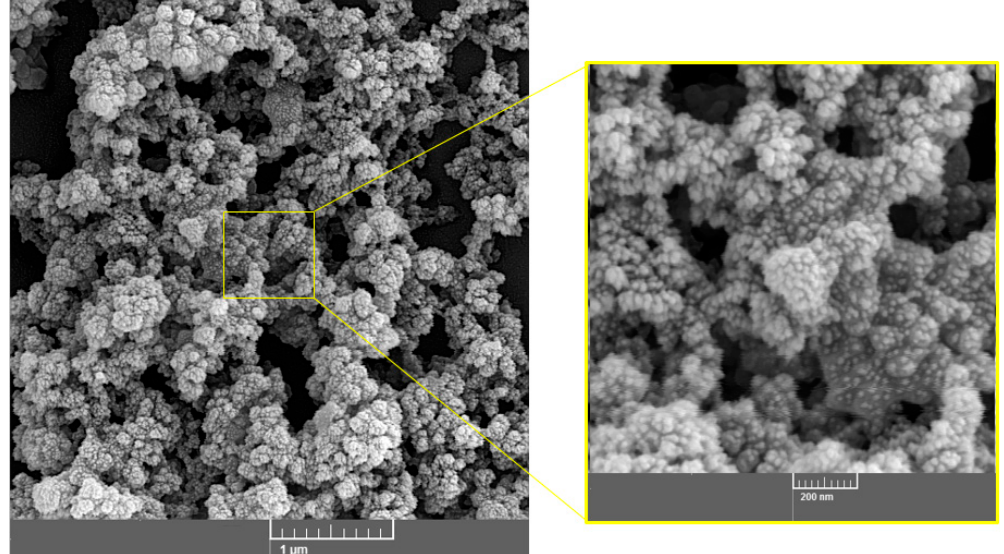
Figure 3. FESEM micrographs of freeze-dried nanocomposite microgel.